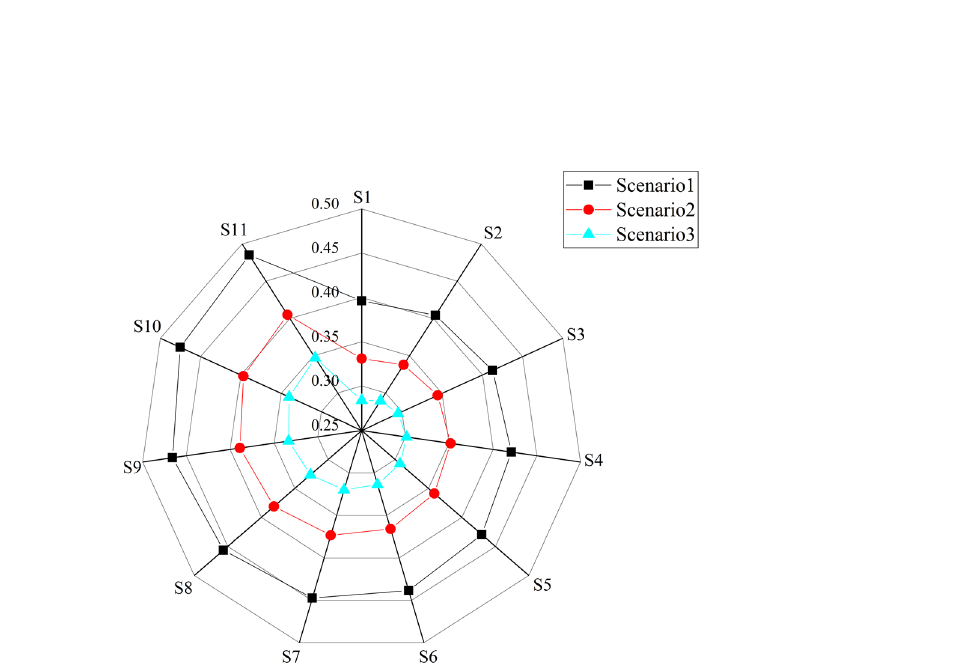
Figure 7. Gini coefficient for the study area under the three